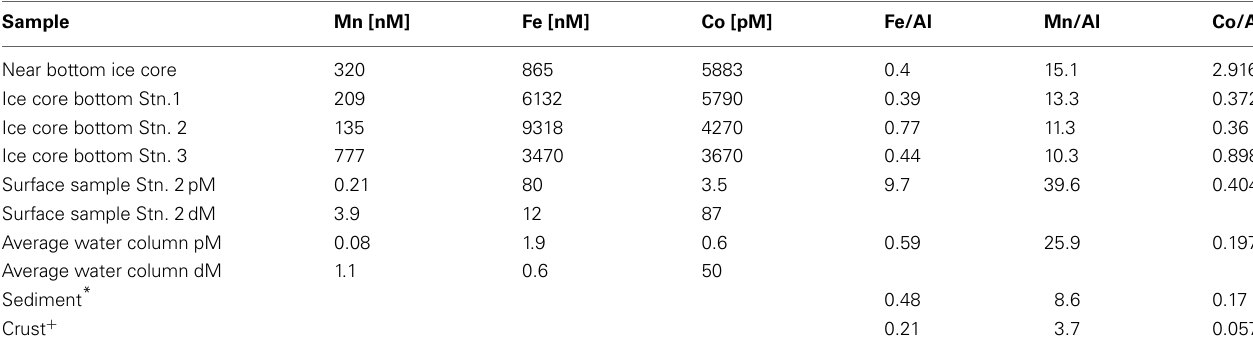
Table 1 | Average metal abundances and ratios to Aluminum from this study and comparison to nearby sediment ( ∗ Ravanelli et al., 1997 and Ianni et al., 2010) and upper crust ( + Taylor and McLennan,